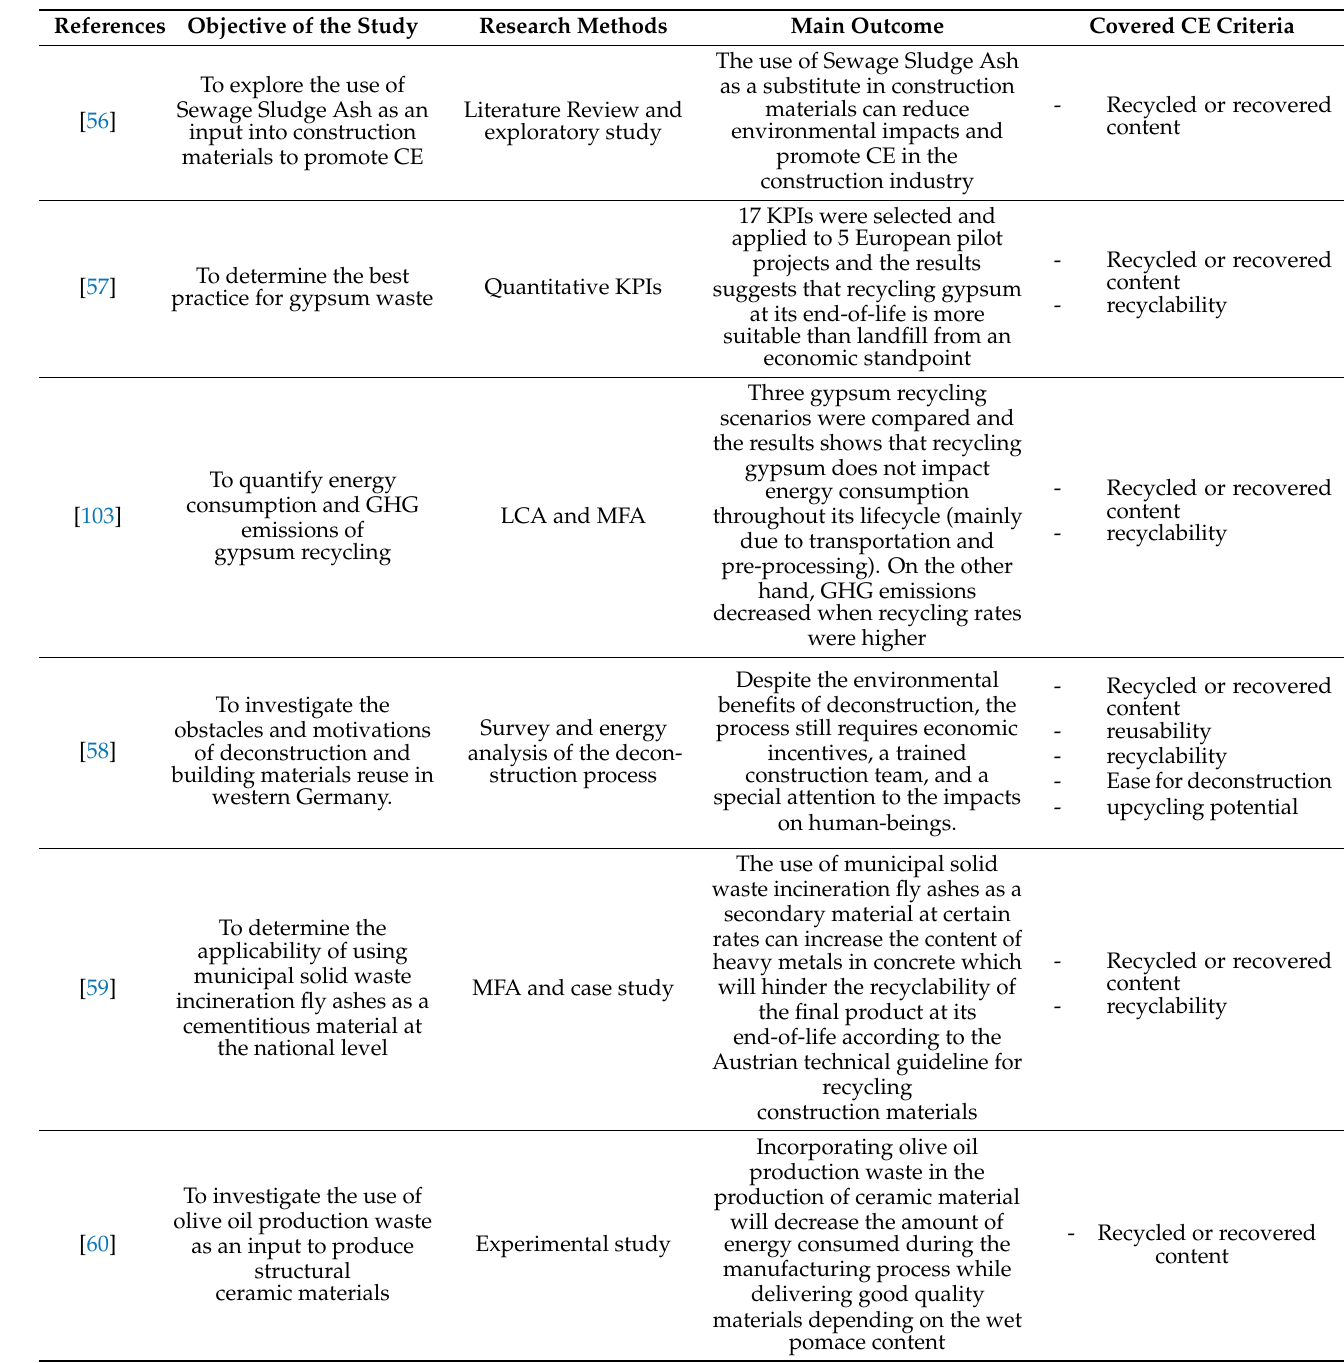
Table A1. Summary of the reviewed journal